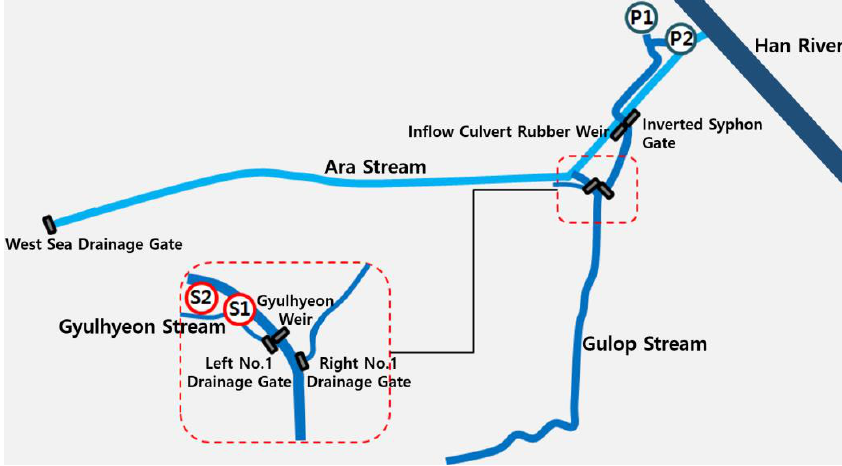
Figure 6. Locations of Major Structures. Table 2. Structural Specifications and Operation Plans.